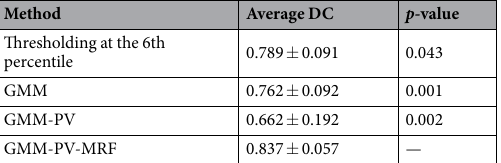
Table 3. Average Dice coefficients (DCs) ( ± standard deviations) for automatic segmentations of myelin-like signals in deep brain region compared with manual segmentations for 16 test subjects aged between 29 and 44 gestational weeks. GMM-PV-MRF is compared with all the other methods using two-tailed Student’s t -tests at the 5% significance level.